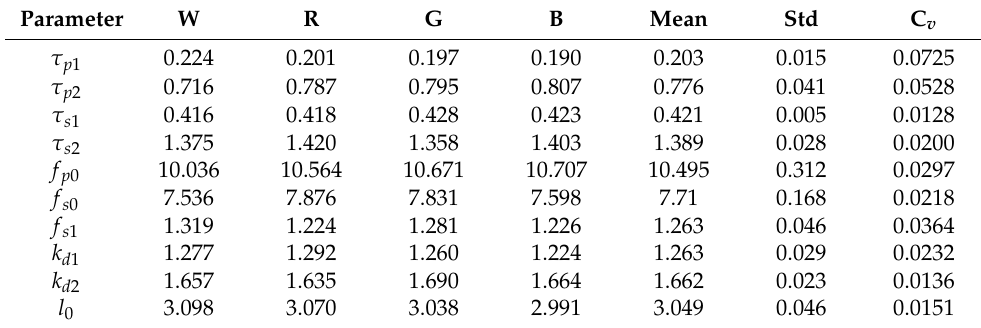
Table 6. Model parameters of measured pupillary response in different stimulus durations.